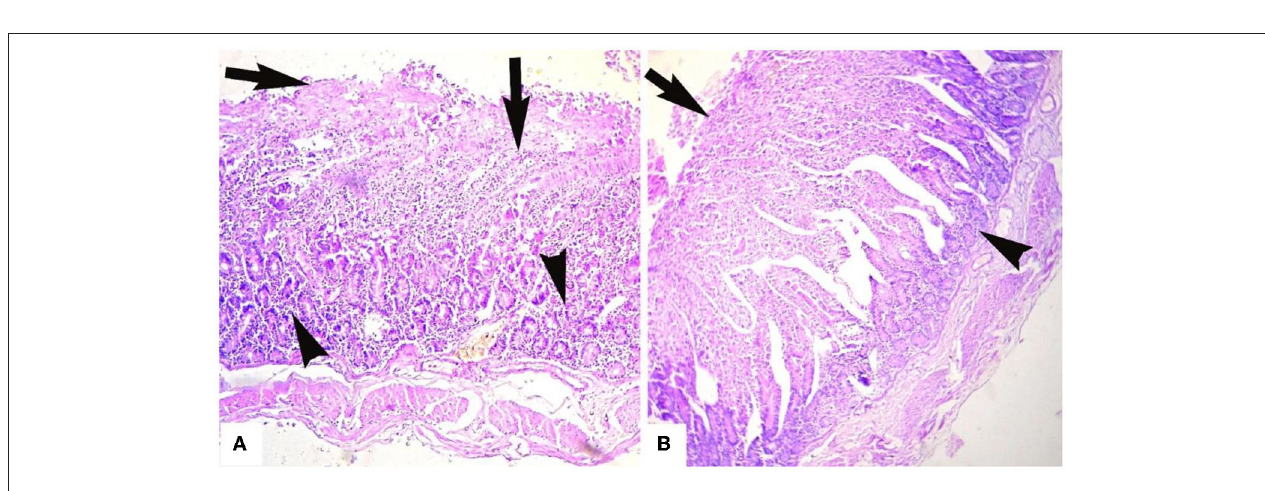
FIGURE 3 | Microphotograph of intestines of goats that died of enterotoxamia showing (A) extensive infiltration of inflammatory cells in glandular part (arrowheads) and extending to up to the villi, necrosis of the villi (arrows) and (B) stunting, fusion, and necrosis of the intestinal villi (arrow) and infiltration of inflammatory cells in the glandular portion (arrowhead). H and E stain. × 40.